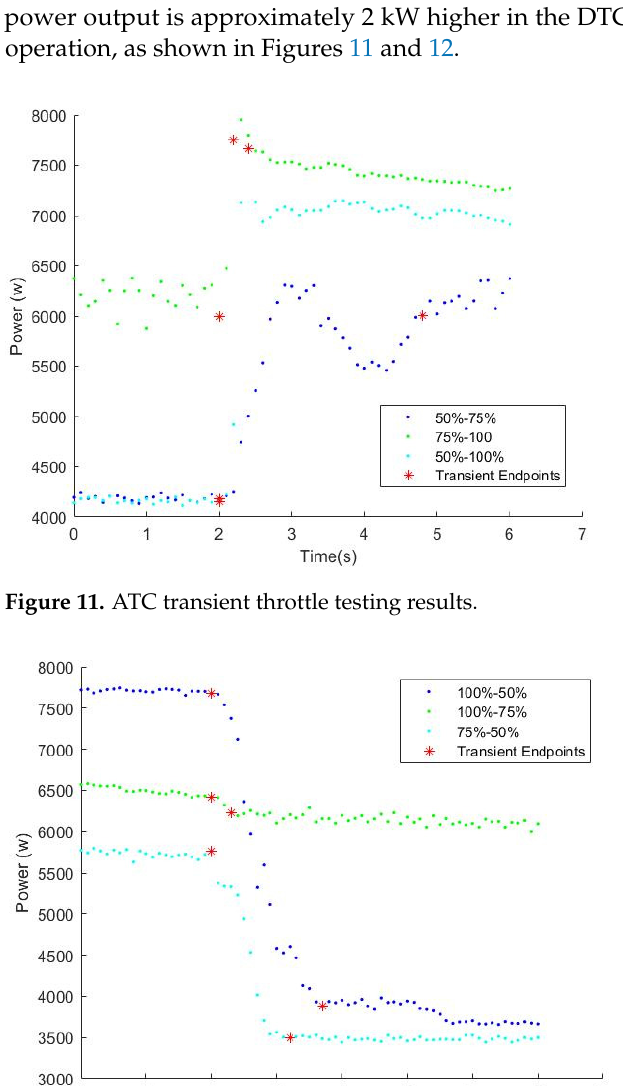
Figure 10. Negative throttle change DTC transient experimentation results.